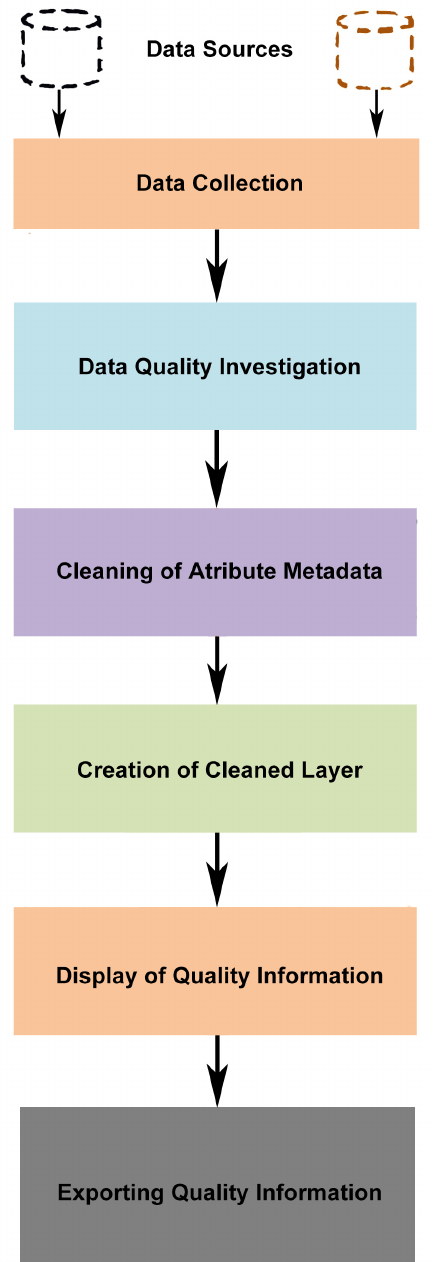
Fig. 2. Framework of the GeoWebCln tool.